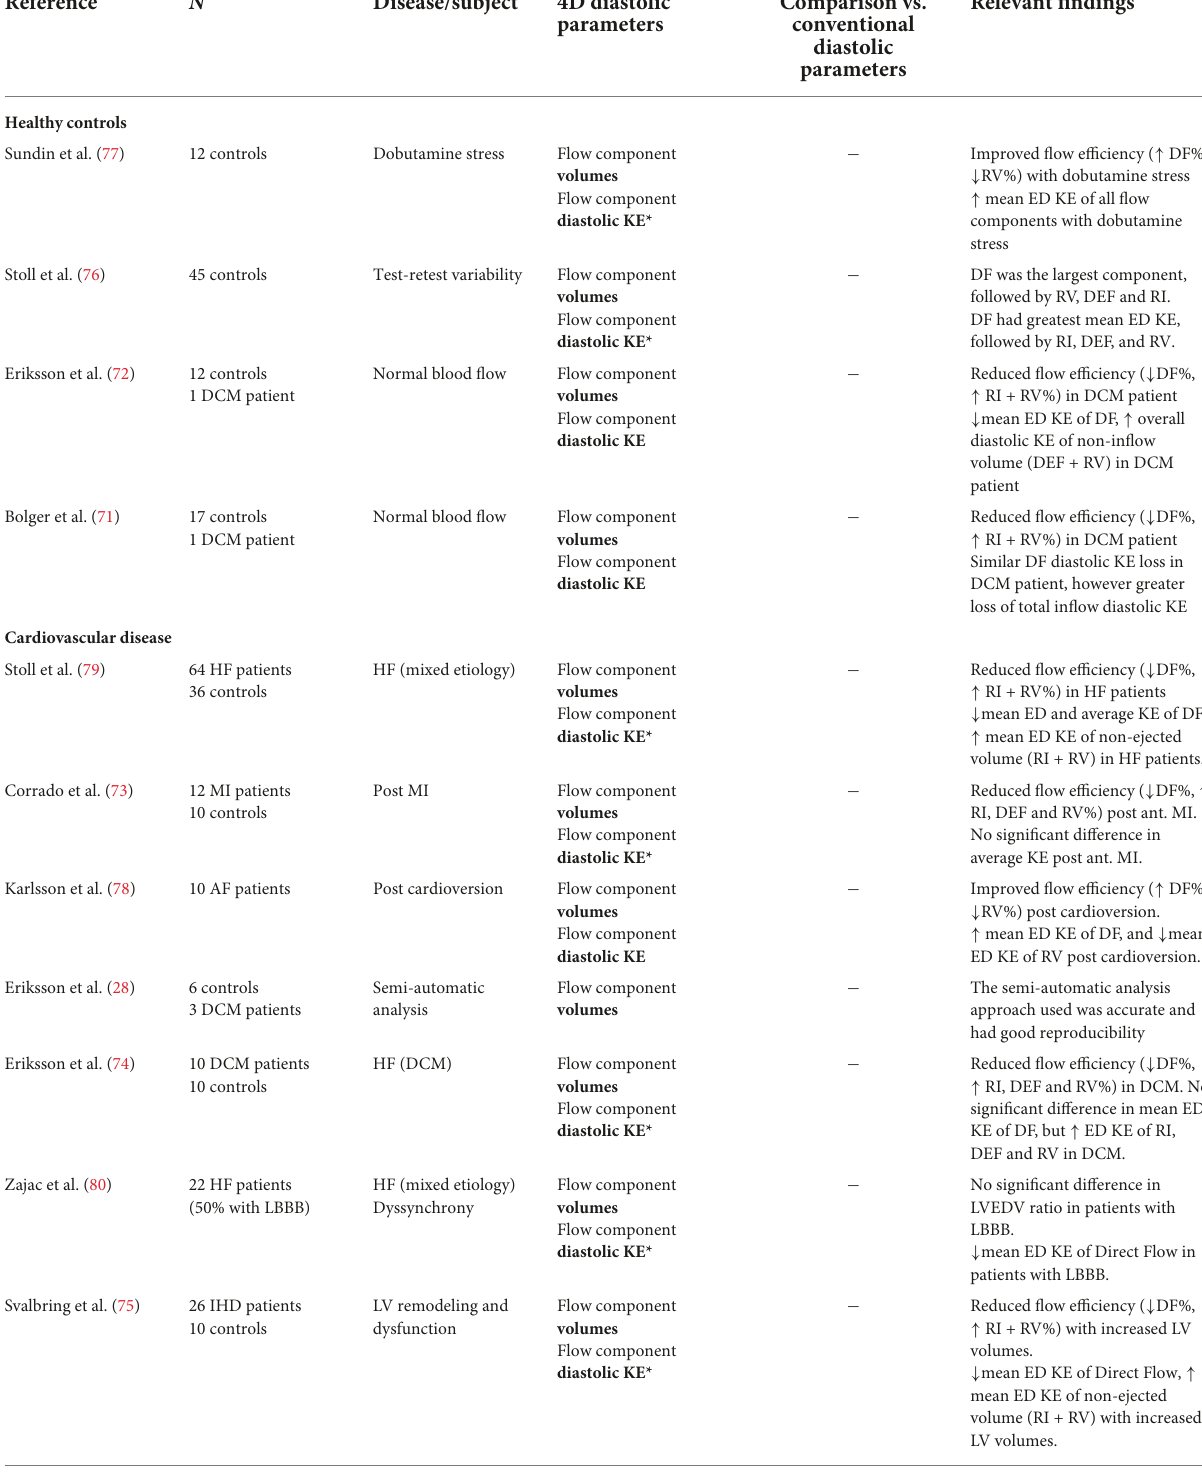
TABLE 5 Four-dimensional flow CMR studies assessing eft ventricular diastolic function using flow component